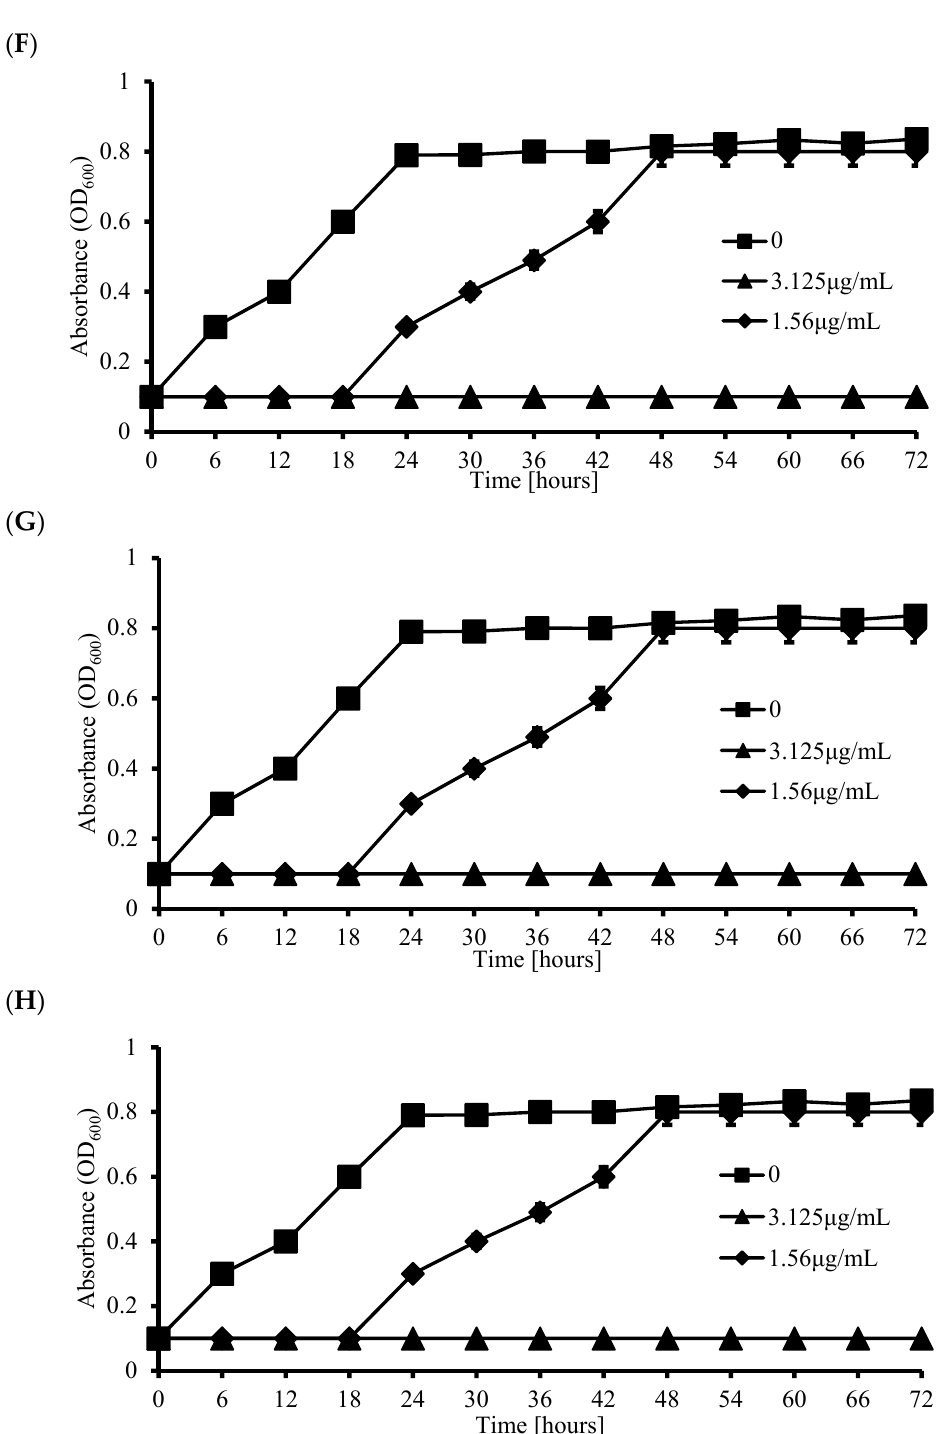
Figure 3. The antimicrobial activity of KHQ 711, 712, 713, 714, 715, 716, 717 and 718. P. gingivalis cultures were treated with ( A ) KHQ 711 (6.25 and 3.125 μ g/mL), ( B ) KHQ 712 (3.125 and 1.56 μ g/mL), ( C ) KHQ 713 (1.56 and 0.78 μ g/mL), ( D ) KHQ 714 (12.5 and 6.25 μ g/mL), ( E ) KHQ 715 (3.125 and 1.56 μ g/mL), ( F ) KHQ 716 (3.125 and 1.56 μ g/mL), ( G ) KHQ 717 (3.125 and 1.56 μ g/mL) and ( H ) KHQ 718 (3.125 and 1.56 μ g/mL) at 37 °C for 72 h and check the growth at every 6 h.